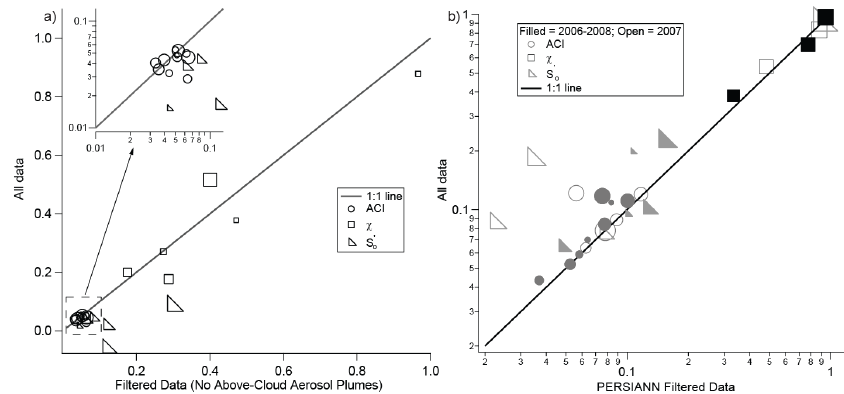
Figure 3. Satellite data analysis of the sensitivity of aerosol-cloud-rain metrics to above-cloud aerosol plumes and wet scavenging. (a) Comparison of ACI, χ , and S 0 o with and without above-cloud aerosol plumes off the coast of western Africa. The data represent the time period between June and October 2006. Marker sizes are proportional to LWP [11 LWP bins with up to 10% spacing around bin midpoints (LWP + 10% × LWP), which increase in 25gm − 2 increments from 50 to 300gm − 2 ]. (b) Comparison of ACI, χ , and S 0 o with and without filtering of wet scavenging events prior to A-Train overpasses within the same 1 ◦ × 1 ◦ pixel. Marker sizes are proportional to LWP (12 LWP bins with up to 10% spacing around bin midpoints, which include 50gm − 2 , 100gm − 2 , and up to 1100gm − 2 in 100gm − 2 increments). The data represent the JJA months for the three year period including 2006–2008 (filled) and 2007 only (open). Only points are reported in both panels that were statistically significant at 95% confidence (based on student’s t-test) with and without the data filtering.